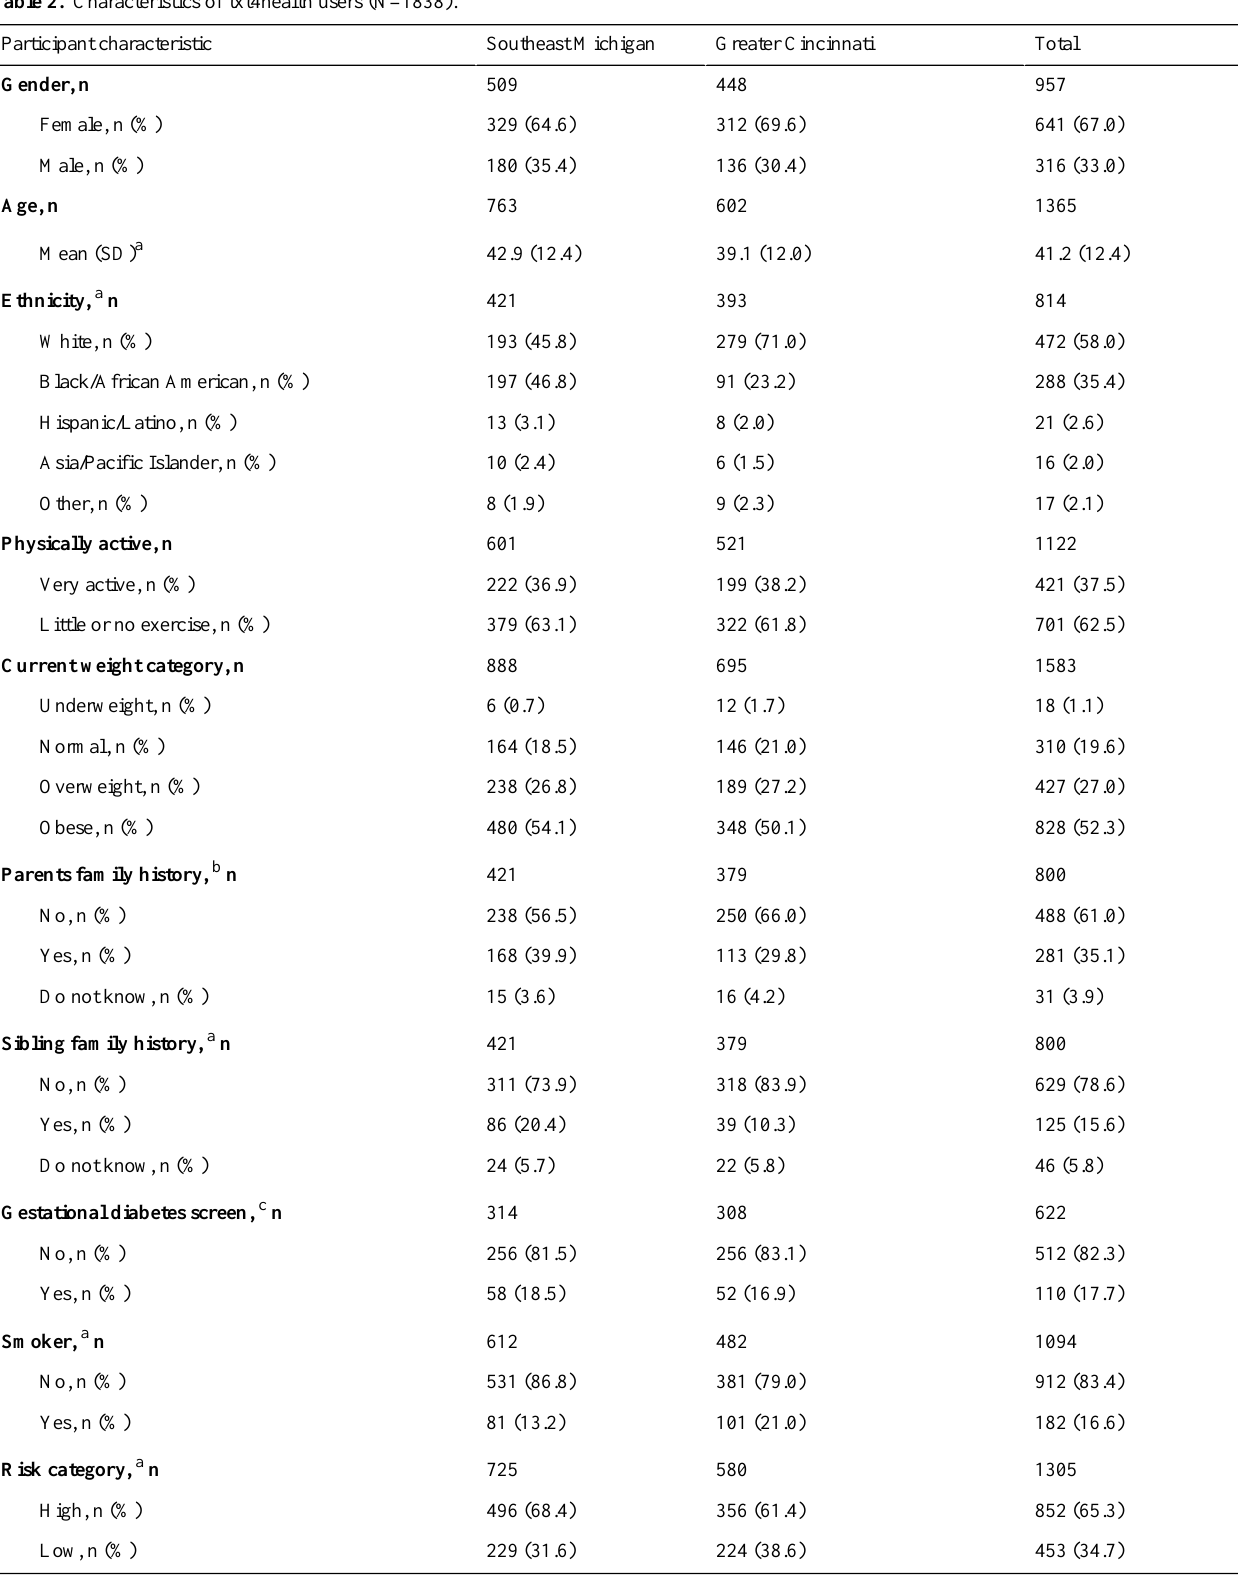
Table 2. Characteristics of txt4health users